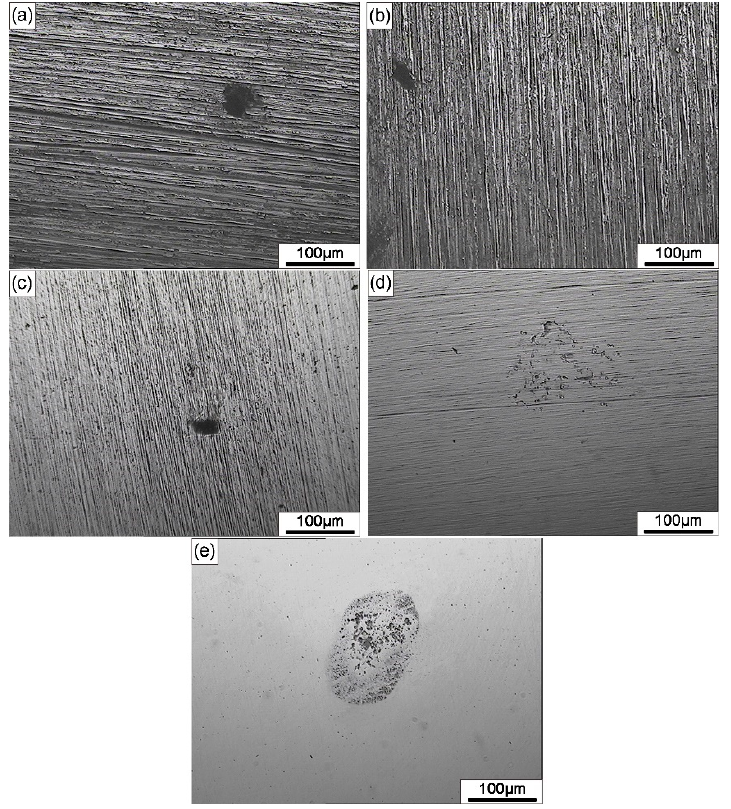
Figure 3. Optical microscopy images of the pits on different surface roughness specimens after EN measurement in 10% FeCl 3 solution at 50 °C: ( a ) 180#; ( b ) 600#; ( c ) 1000#; ( d ) 2000#; ( e ) polished.